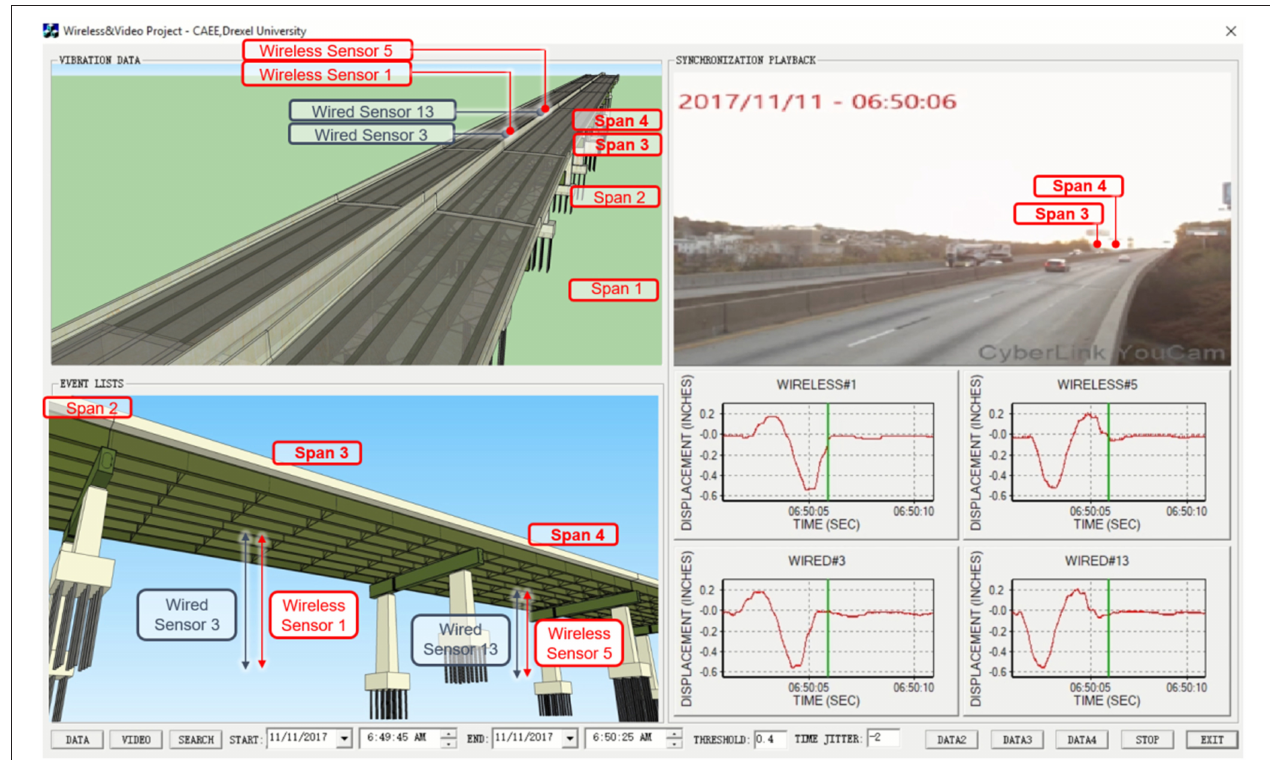
FIGURE 8 | Operational monitoring of the I76 viaduct: traffic